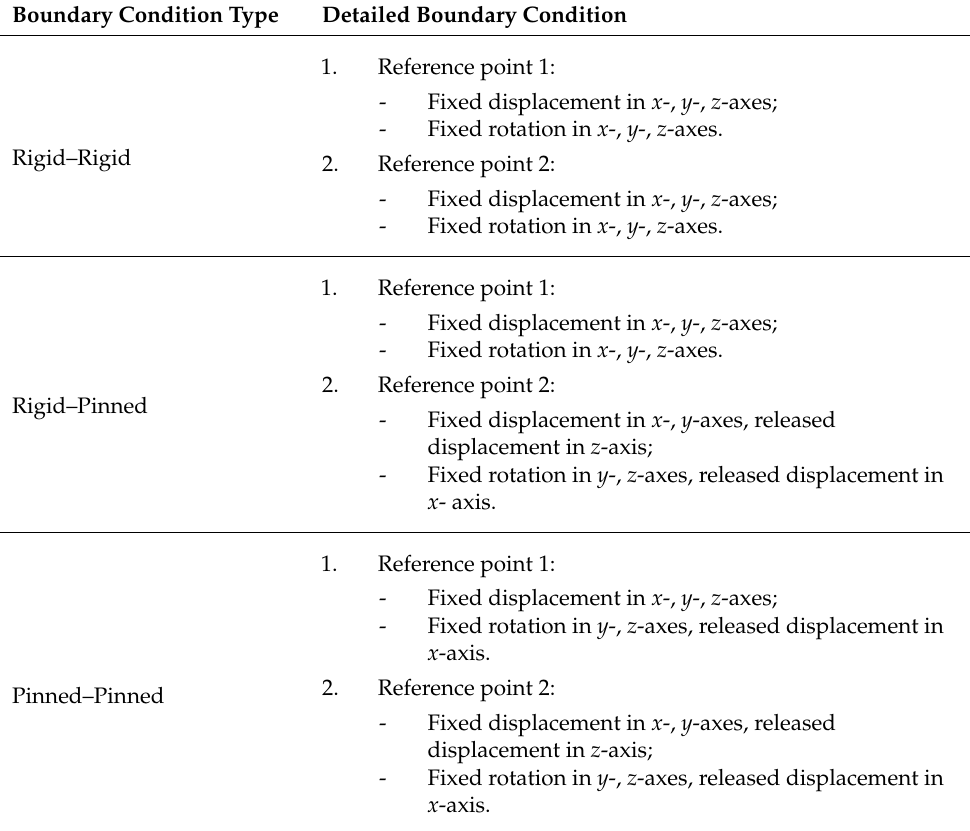
Table 16. Boundary conditions in the developed numerical